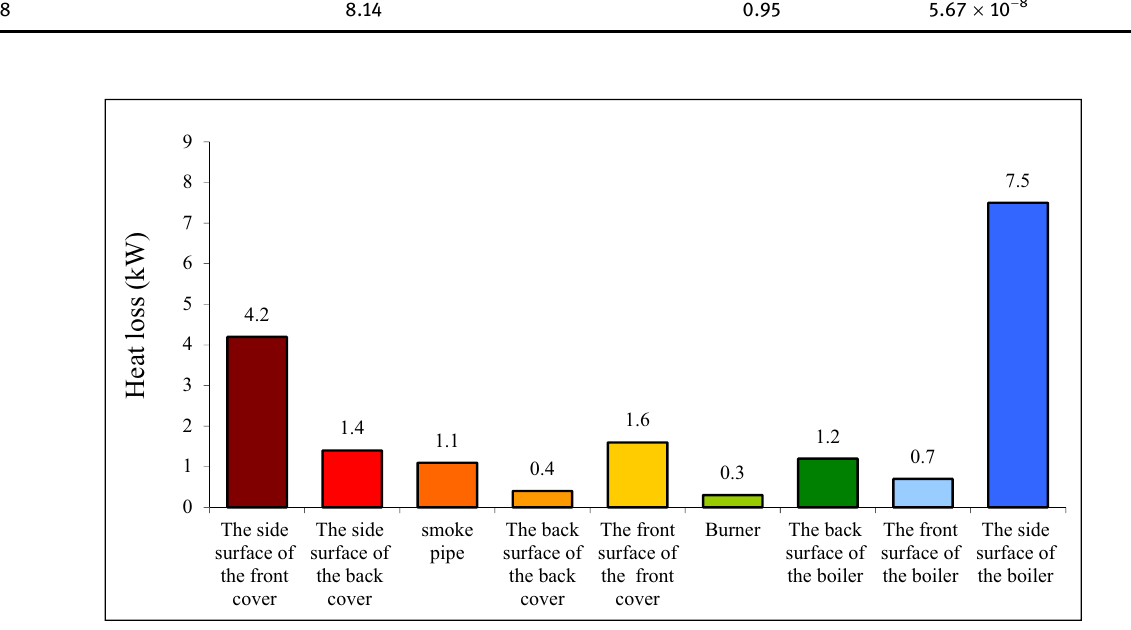
Figure 2: Distribution graph of steam boiler heat losses before improvement works.